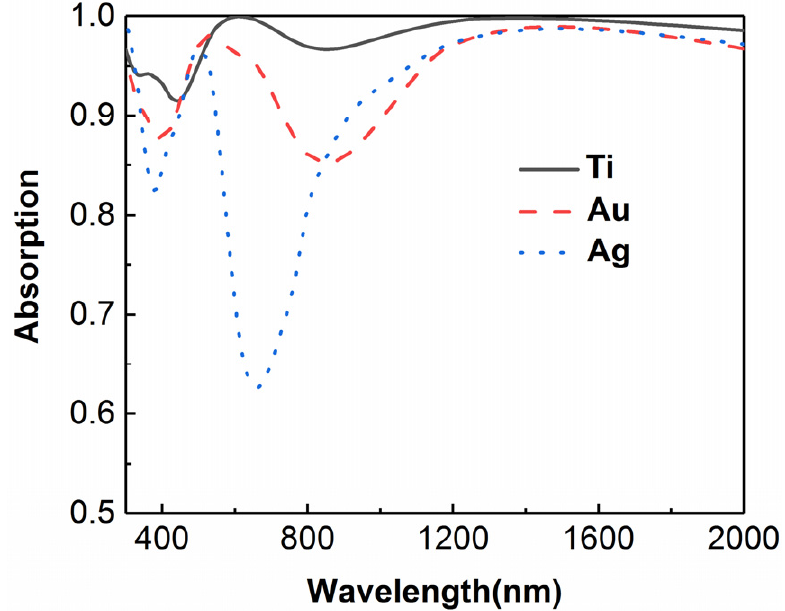
Figure 10. Comparison of light absorption as the metallic material changes. Another concerning characteristic of solar absorbers for practical application is the response of the absorber to the polarization and the incident angle. Figure 11 presents the evolution of absorptance as the polarization angle and the angle of incidence change. When the angle of incidence increases from 0 ◦ to 60 ◦ , there are almost no changes in the absorptance, except in the short-wavelength range. As the polarization angle changes from 0 ◦ to 60 ◦ , the overall absorber can maintain a good absorption efficiency in the full range of 300~2000 nm. The results show that the structure of the cross and the underlying plane coupling can have a better absorptance on the broader range and present an angle- insensitivity and